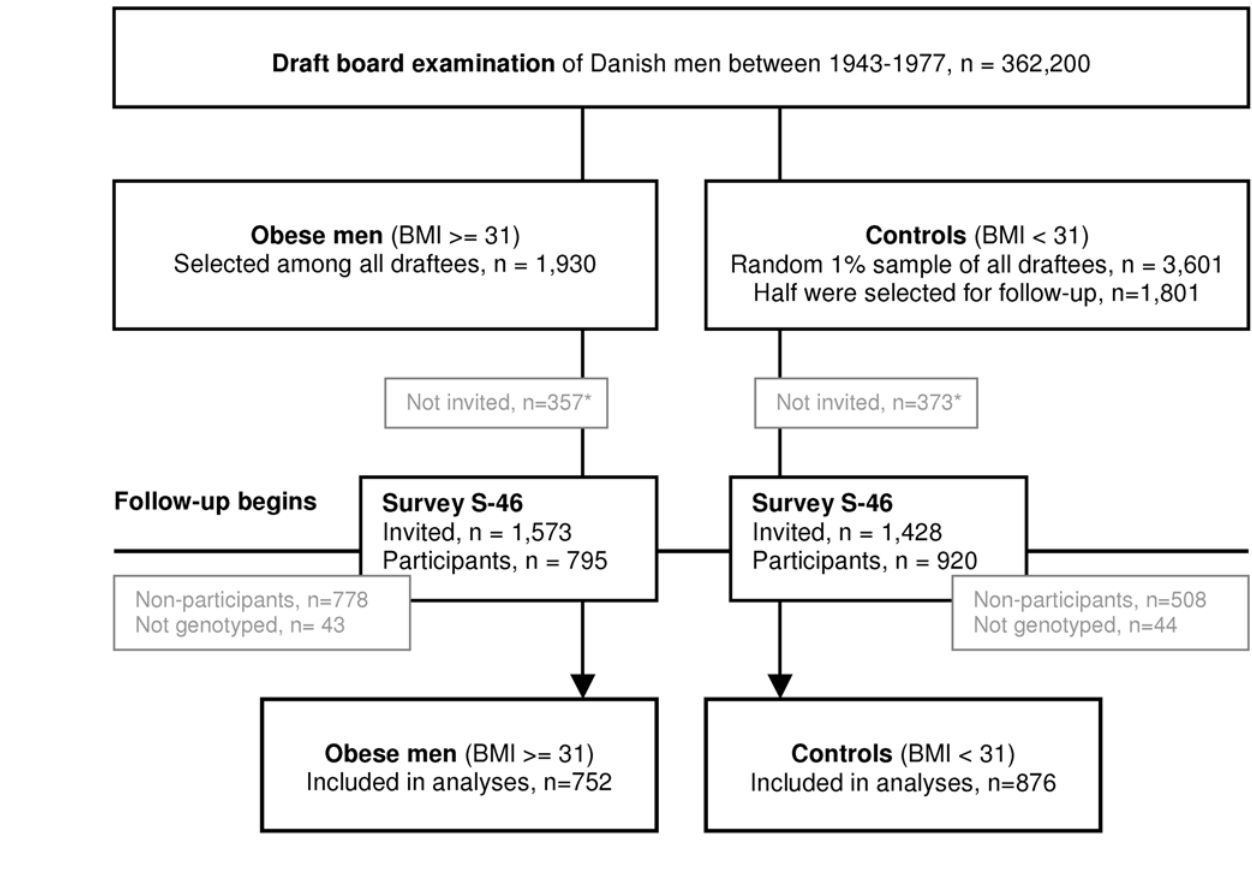
Figure 1. Participation flow chart from draft board examination.